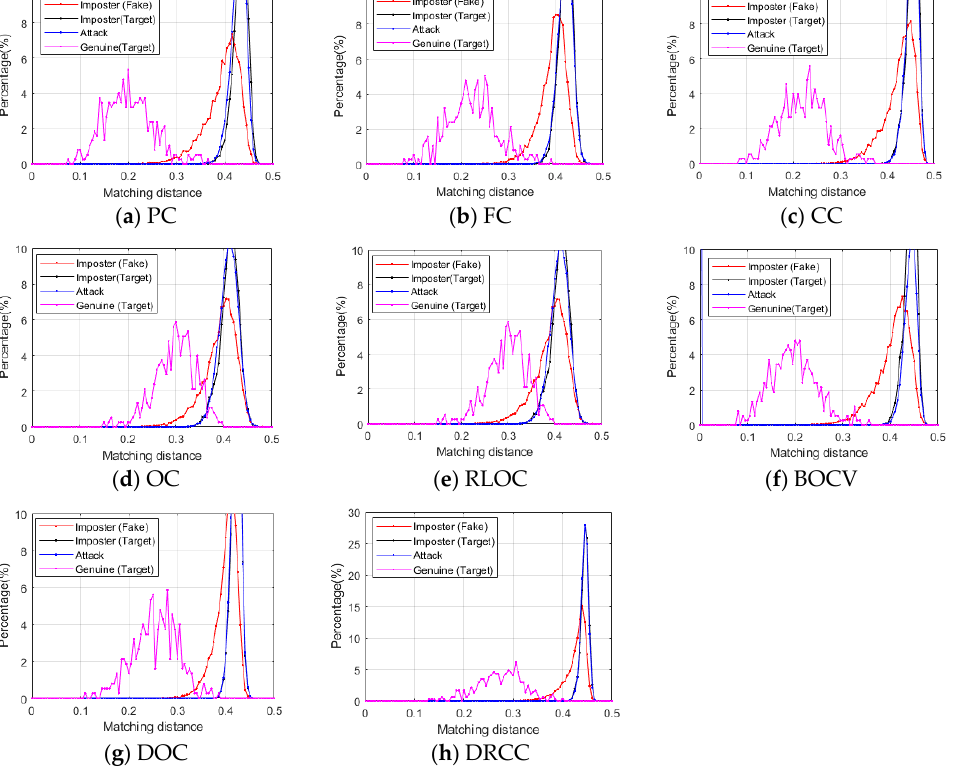
Figure 11. Four distance distributions. ( a ) palm code (PC), ( b ) fusion code (FC), ( c ) competitive code (CC), ( d ) ordinal code (OC), ( e ) robust line orientation code (RLOC), ( f ) binary orientation co-occurrence vector (BOCV), ( g ) double orientation code (DOC), and ( h ) discriminative and robust competitive